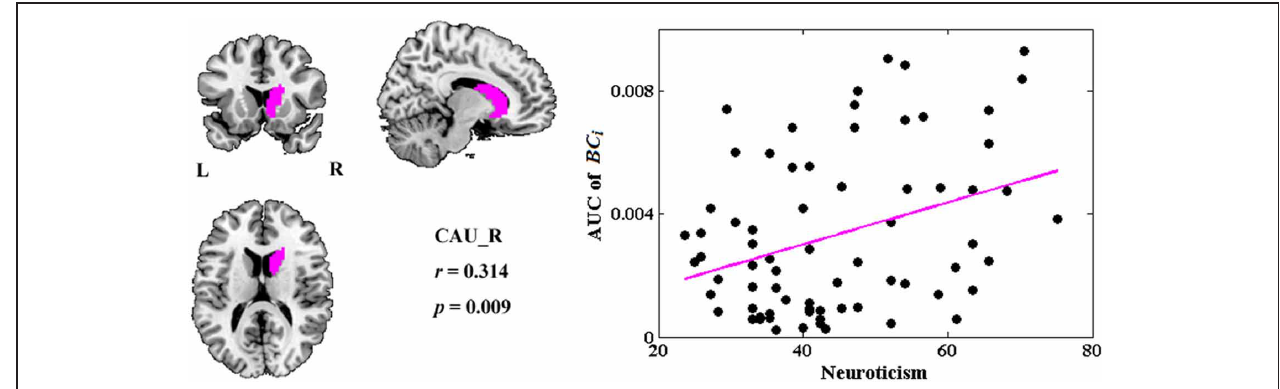
FIGURE 4 | The brain regions showing significantly correlations between AUC of BC i and neuroticism scores ( p < 1 . 90). AUC was calculated over the range of 0 . 1 ≤ T ≤ 0 . 31 with an interval of 0.01. AMYG, amygdala; CAU, caudate nucleus; L, left; OLF, olfactory cortex; PreCG, precentral gyrus; R, right.